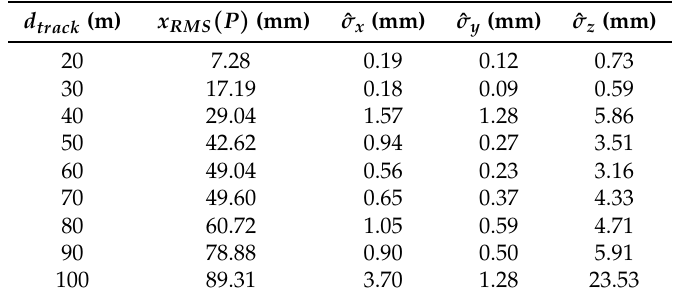
Table 4. Relative point accuracy and standard deviation ˆ σ C for d base ≈ 9